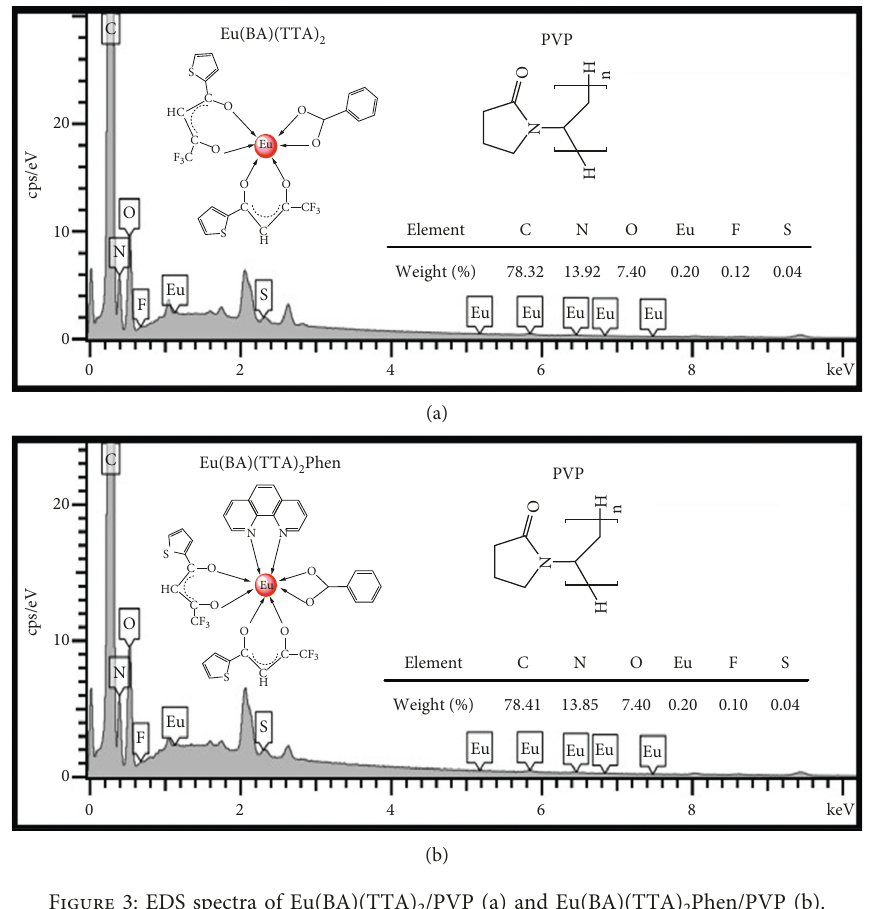
Figure 3: EDS spectra of Eu(BA)(TTA) 2 /PVP (a) and Eu(BA)(TTA) 2 Phen/PVP